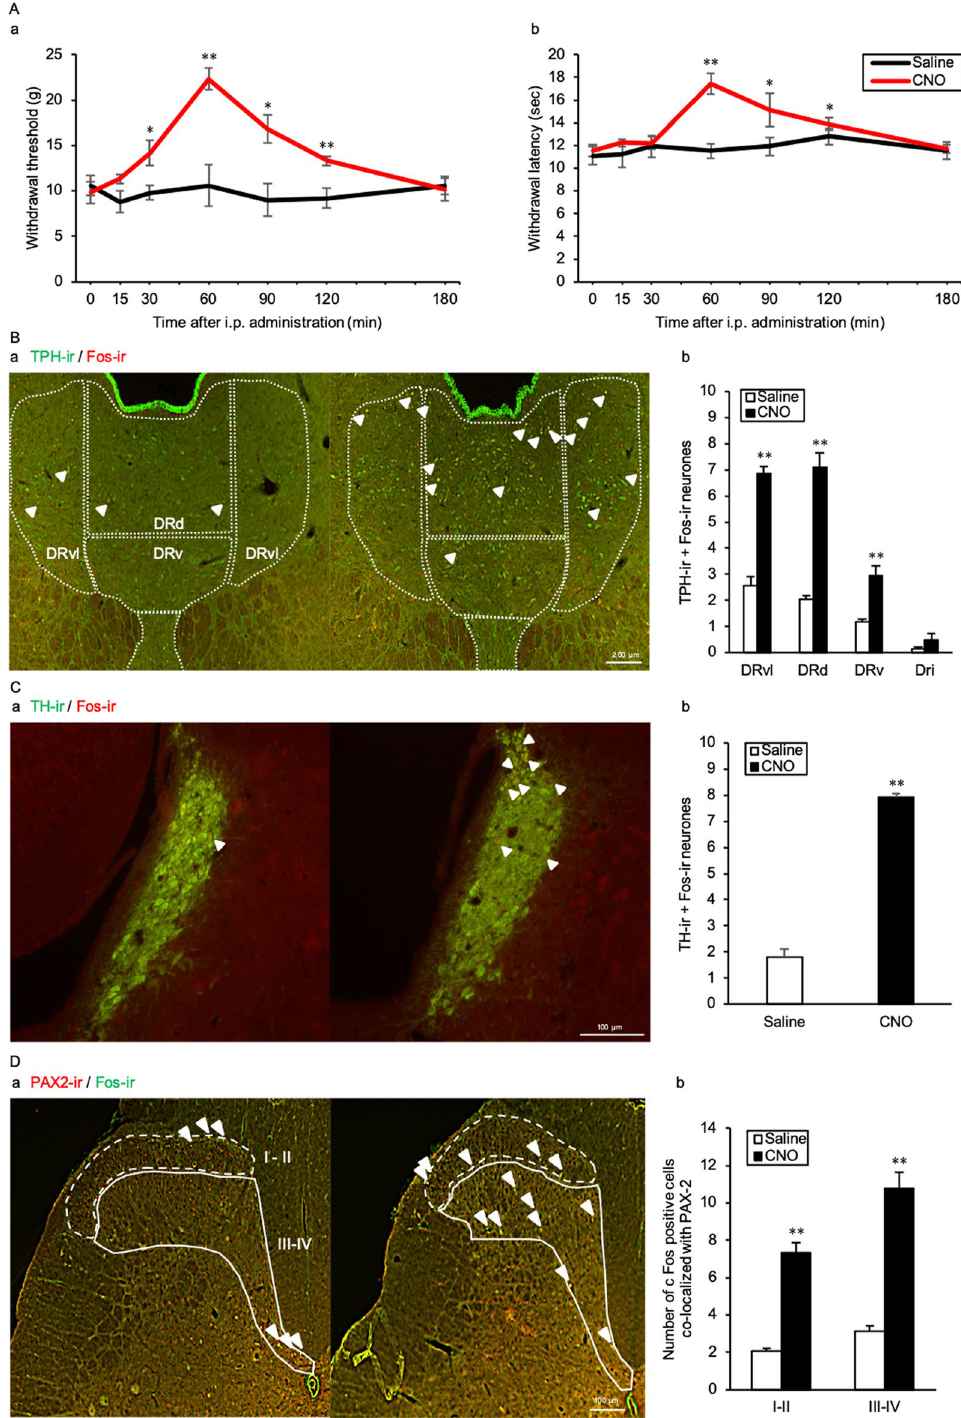
Figure 7. AVP neurones activate serotonergic neurones in the DR, noradrenergic neurones in the LC and PAX-2 positive interneurones of the spinal dorsal horn. ( A ) Time course of ( a ) mechanical and ( b ) thermal nociceptive threshold after CNO or saline intraperitoneal (i.p.) injection. Data are presented as the mean ± SEM (Student’s t -test). * p < 0.05 and ** p < 0.01 compared with each Saline experiment. ( B ) ( a ) Fluorescence microscopic images of tryptophan hydroxylase (TPH)-ir (green) and Fos-ir (red) positive neurones in the dorsal raphe (DR). ( b ) The number of TPH-ir and Fos-ir positive neurones in the DR. Data are presented as the mean ± SEM (Student’s t -test). * p < 0.05 and ** p < 0.01 compared with each Saline. ( C ) ( a ) Fluorescence microscopic images of tyrosine hydroxylase (TH)-ir (green) and Fos-ir (red) positive neurones in the locus coeruleus (LC). The number of TH-ir and Fos-ir positive neurones in the LC. Data are presented as the mean ± SEM (Student’s t -test). ** p < 0.01 compared with Saline. The fluorescence microscopic images of paired box gene-2 (PAX-2)-ir (red) and Fos-ir (green) positive cells in the lumber segment 5 (L5) ipsilateral dorsal horn. ( b ) The number of PAX-2-ir and Fos-ir positive cells in the L5 spinal dorsal horn. Data are presented as the mean ± SEM (Student’s t -test). n = 6 in each group. ** p < 0.01 compared with